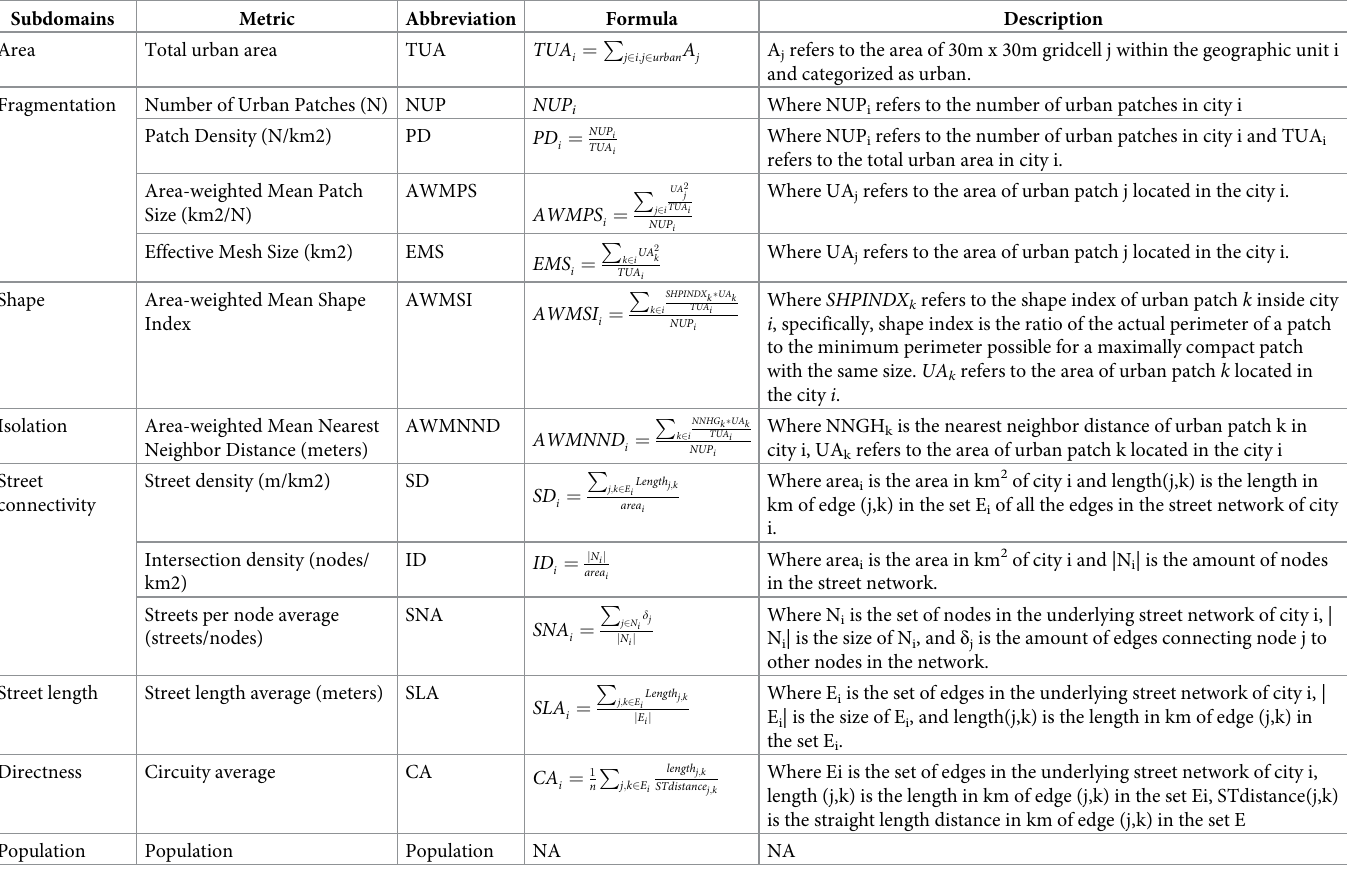
Table 1. Urban development landscape and street design domains, subdomains, and population metrics. Subdomains Formula